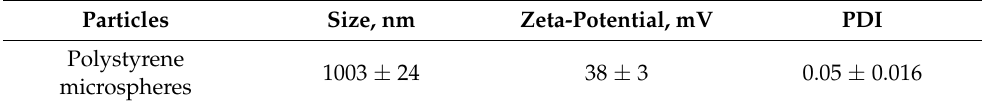
Table 1. Physiochemical characterization of